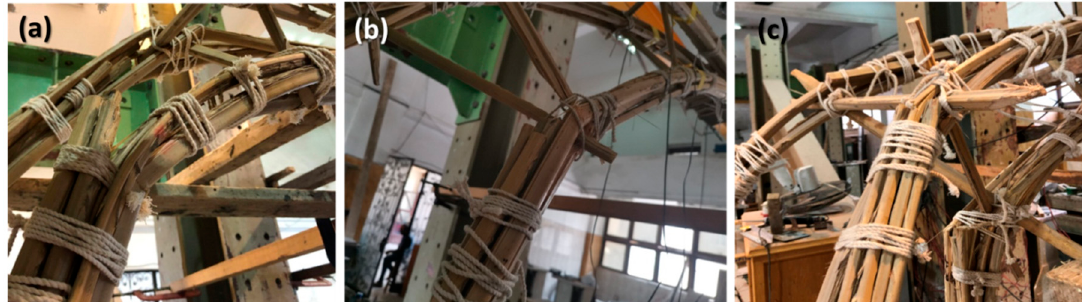
Figure 22. The failure in the specimens. ( a ) Longitudinal cracks and breaking failure in the overlapping area in the first specimen. ( b ) The breaking failure and the longitudinal cracks above and through the overlapping area in the second specimen. ( c ) The breaking failure and the longitudinal cracks in the third specimen.